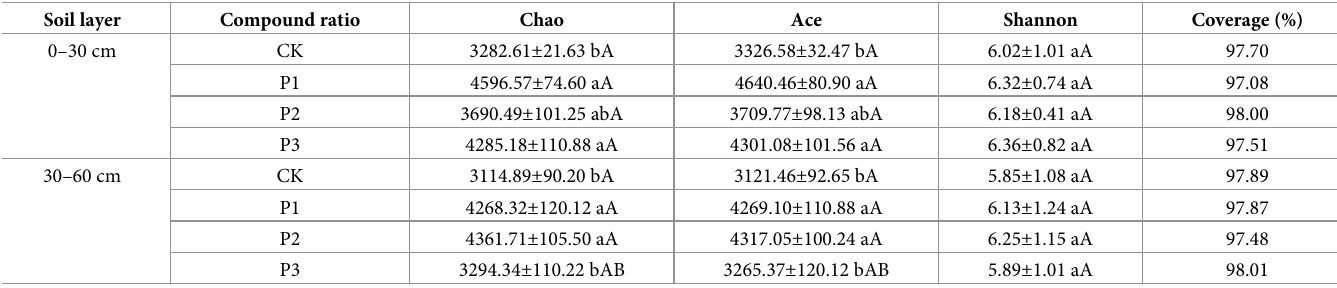
Table 2. Bacterial diversity of compound soil under different soil